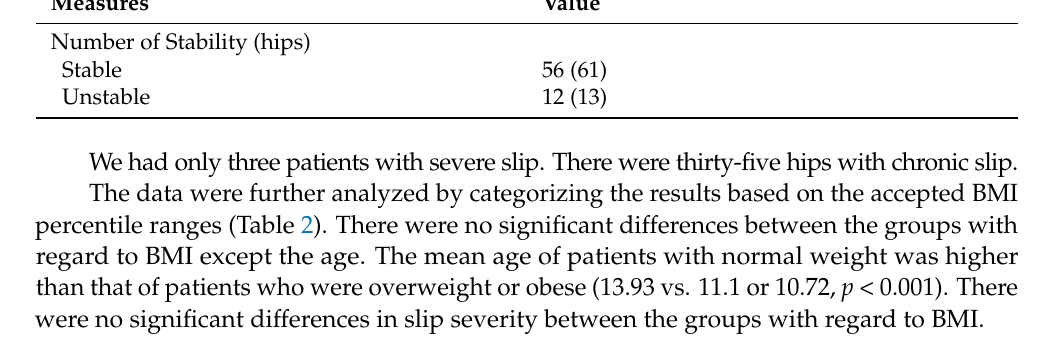
Table 2. Categorizing results based on the accepted BMI percentile ranges.